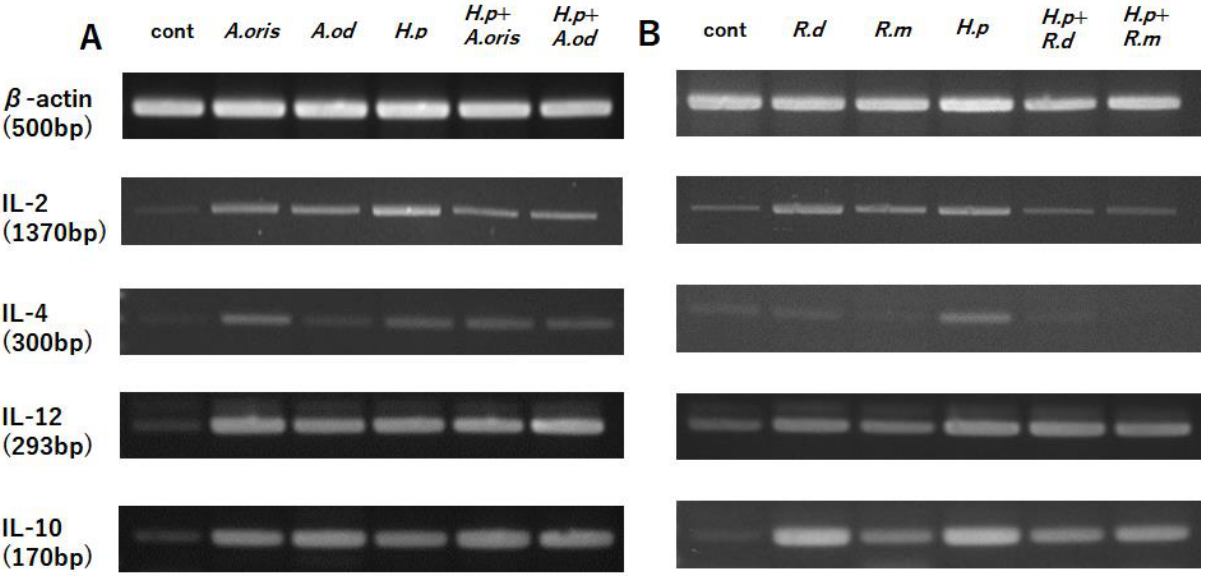
Figure 2. Transcription of cytokine mRNA. The mRNA transcription levels of cytokines (IL-2, IL-12, IL-4, and IL-10) were detected using RT-PCR and gel electrophoresis. ( A ) Stimulation with Actinomyces spp. and/or H. pylori ; ( B ) stimulation with Rothia and/or H. pylori.